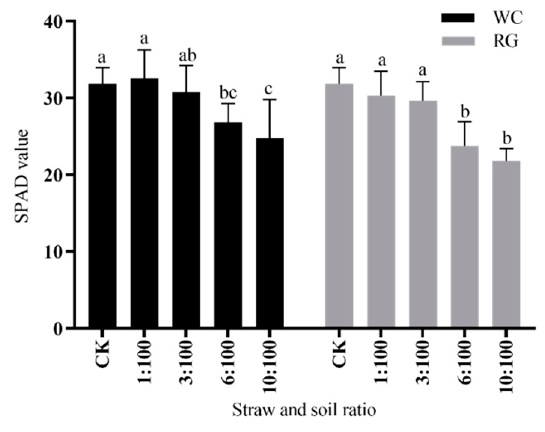
Figure 8. Effect of cover crops turnover on SPAD value of corn. Different lower-case letters represent significant differences ( p < 0.05) between treatments in RG and WC. The bar represents mean values of 5 replicates ± SD. Table 5. Effect of different soil and straw ratio of WC and RG on corn fluorescence properties [mean ± (SD); n =